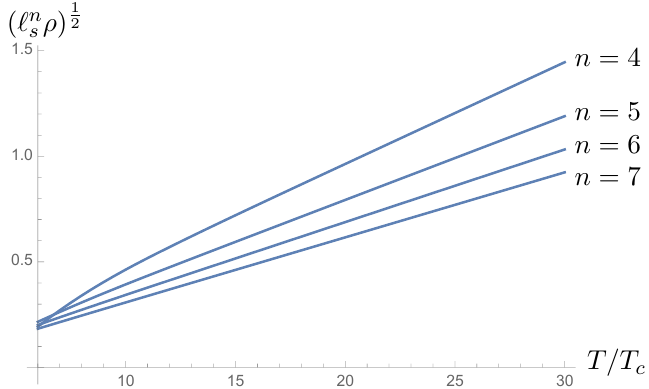
Figure 6 . The square root of the energy density in the high temperature regime in dimensions n = 4 , 5 , 6 , 7 . Choice of parameters: m B = 0 . 1 , m F = 0 . 2